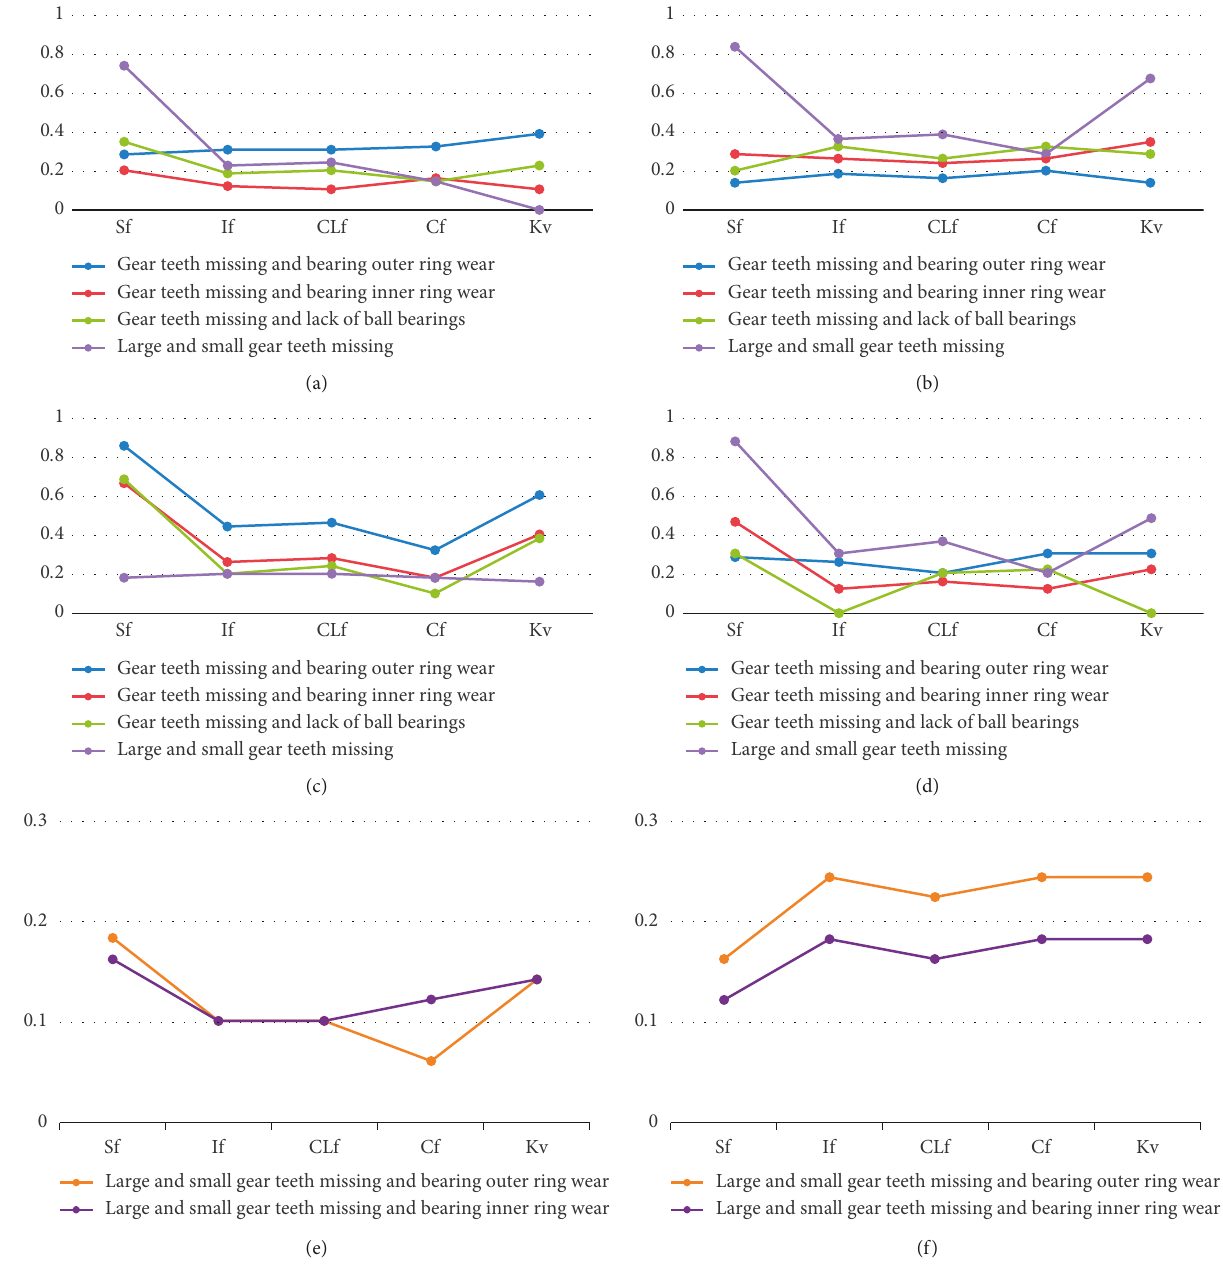
Figure 6: Different faults and the distribution of five dimensionless indexes based on k values; Sf: waveform index. If: impulse index. CLf: margin index. Cf: peak index. Kv: kurtosis index. (a) Fault sample 1. (b) Fault sample 2. (c) Fault sample 3. (d) Fault sample 4. (e) Fault sample 5. (f) Fault sample